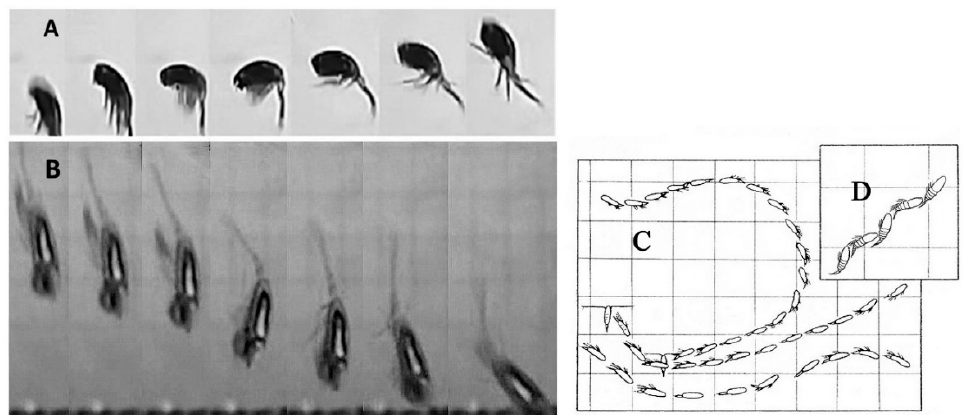
Figure 5. Instantaneous body positions of Oithona davisae ( A ) and Limnocalanus macrurus ( B ) during escape kick, the trajectory of three individuals of Calanus helgolandicus stimulated by electrical impulses ( C ), and the instantaneous positions of the body at the end of stroke and recovery phases of kick ( D ). Note, only characteristic body positions are shown in ( A ) and ( B ) (present data). ( C ) and ( D ) are from [31].